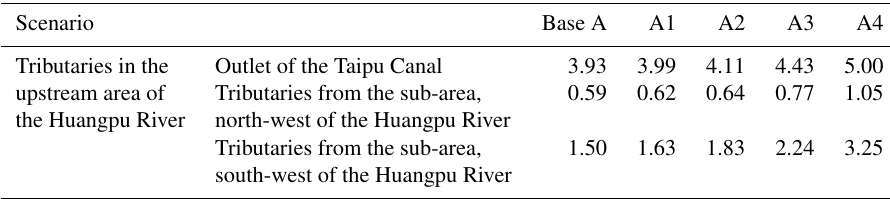
Table 4. Summary of the inflow volumes of the tributaries in the upstream of the Huangpu River from June to August in 1999 under the five scenarios considered in this study (unit: billionm 3 ).